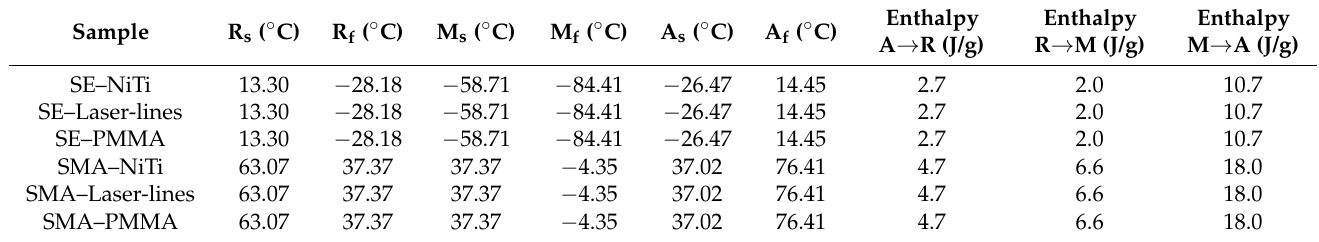
Table 2. Transformation temperatures and enthalpies of NiTi and composite samples. (As such, the temperature accuracy of the Discovery DSC is ± 0.025 ◦ C, equivalent to the